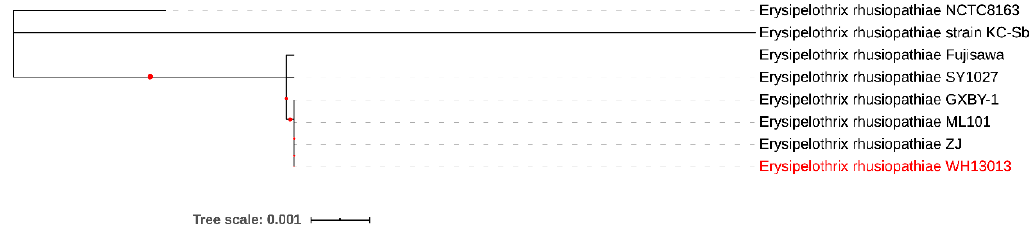
Figure 2. Phylogenetic analysis of different Erysipelothrix rhusiopathiae . The evolutionary history was inferred by using the maximum likelihood method and Tamura–Nei model. The tree with the highest log likelihood ( − 10,888.34) is shown. The percentage of trees in which the associated taxa clustered together is shown next to the branches. Initial tree(s) for the heuristic search were obtained automatically by applying neighbor-join and BioNJ algorithms to a matrix of pairwise distances estimated using the maximum composite likelihood (MCL) approach, and then selecting the topology with a superior log likelihood value. The tree is drawn to scale, with branch lengths measured in the number of substitutions per site. This analysis involved 8 nucleotide sequences. There was a total of 7323 positions in the final dataset. Evolutionary analyses were conducted in MEGA X.